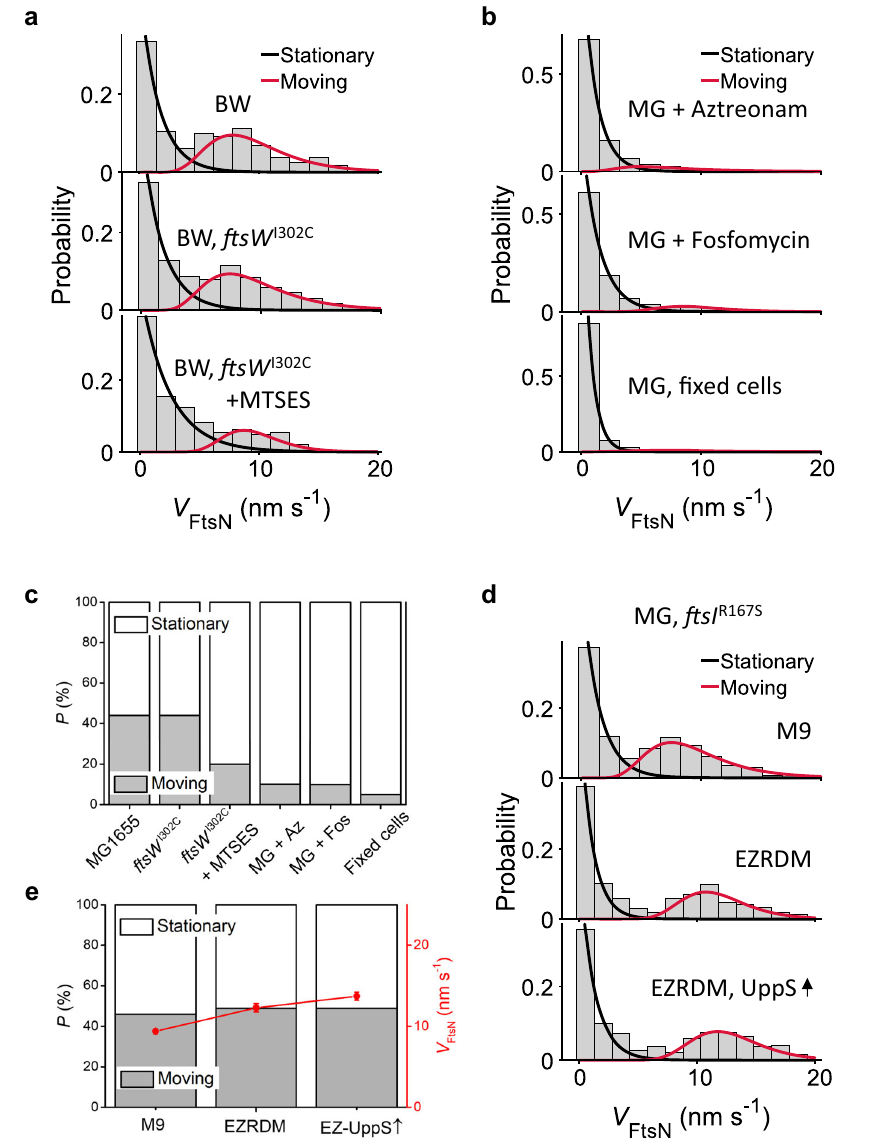
Fig.3|FtsN ’ sprocessivemovingpopulationisdrivenbysPGsynthesisactivity. a Speeddistributionsandthecorresponding fi tcurvesofthestationary(black) and moving (red) populations of single FtsN-Halo SW molecules in the BW25113 WT (top) and ftsW I302C variant strain in the absence (middle) or presence (bottom) of MTSES. b Speed distributions of single FtsN-Halo SW molecules in the MG1655 WT strain treated with aztreonam (top) or fosfomycin (middle). Fixed cells without antibiotic treatment are shown as a control (bottom). c Percentage of the processively moving population of FtsN (gray bar) gra- dually decreased when sPG synthesis is inhibited under the conditions in